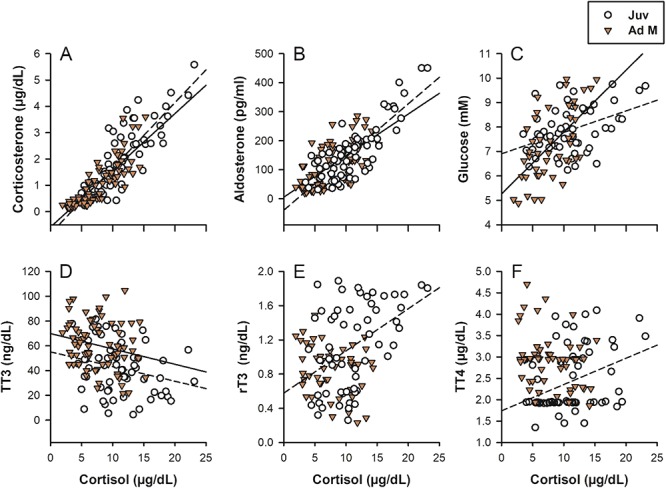
Relationships between markers for stress and metabolism in juvenile (Juv) and adult male (Ad M) sea lions. Separate lines of fit (Juv, dotted; Ad M, solid) are derived from Pearson’s correlations using multivariate comparisons for each age class. Cortisol was significantly positively associated with corticosterone (a, Juv, r = 0.86, P < 0.0001; Ad M, r = 0.85, P < 0.0001), aldosterone (b, Juv, r = 0.83, P < 0.0001; Ad M, r = 0.67, P < 0.0001) and glucose (c, Juv, r = 0.39, P = 0.0009; Ad M, r = 0.67, P = 0.0009), and negatively associated with TT3 (D, Juv, r = −0.14, P = 0.0133; Ad M, r = −0.27, P = 0.0044). rT3 (E, r = 0.45, P = 0.0007) and TT4 (F, r = 0.51, P = 0.009) were positively associated with cortisol in juvenile CSL only.